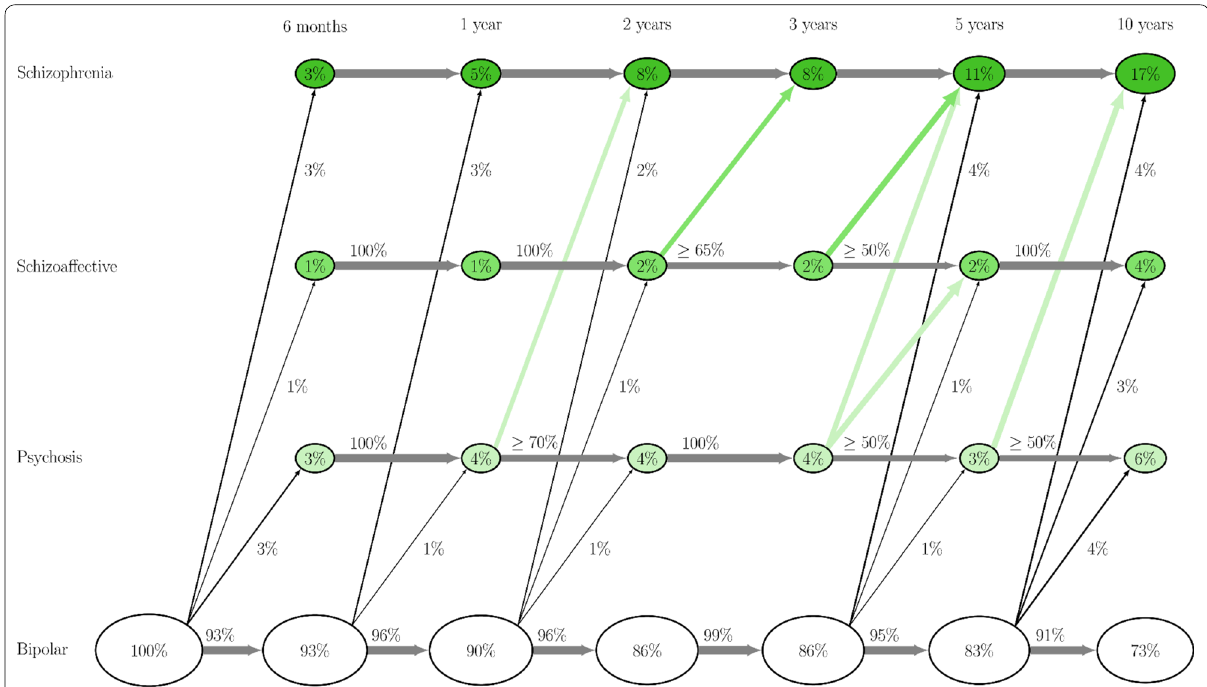
Fig. 1 Percentages of patients who changed diagnosis and patients continuing to have the diagnosis latest given to them. Percentages are computed using the number of patients available in the sample at each time point (N years follow‑up). The sum of the percentages in the ovals for each time point is 100%, as is the sum of the arrow percentages (both horizontal and rightwards), except for rounding errors. Arrows representing less than four patients are depicted as green arrows without percentages if originating from Psychosis (PNOS) or Schizoaffective (SA) groups, or not represented at all if originating from Bipolar (BD)